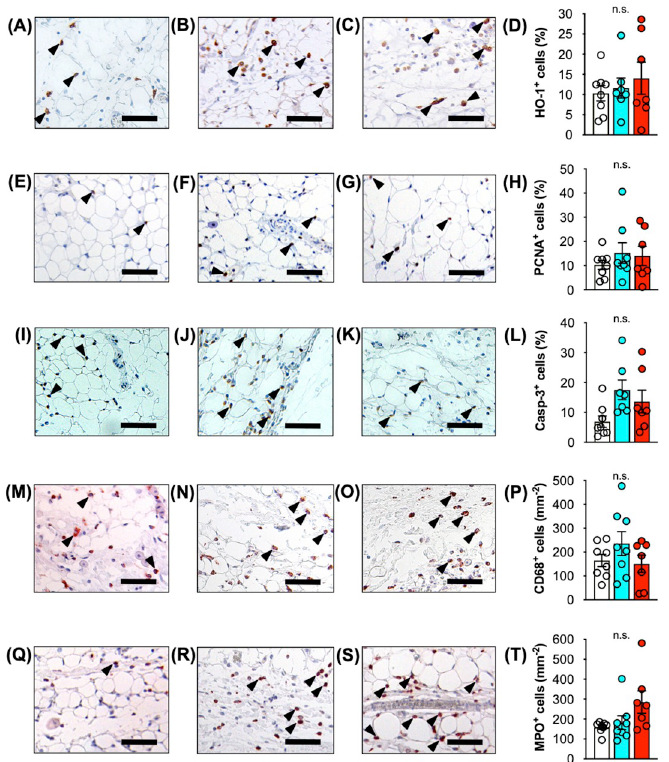
Fig 7. Immunohistochemical analyses of adipose tissue after IR injury. A-D Immunohistochemical detection of HO-1 + cells (arrowheads) in perinodal adipose tissue of control ( A ), IR-45 ( B ) and IR-120 ( C ) VLN flaps. D Quantitative analysis of HO-1 + cells (%). E-H Immunohistochemical detection of PCNA + cells (arrowheads) in perinodal adipose tissue of control ( E ), IR-45 ( F ) and IR-120 ( G ) VLN flaps. H Quantitative analysis of PCNA + cells (%). I-L Immunohistochemical detection of Casp-3 + cells (arrowheads) in perinodal adipose tissue of control ( I ), IR-45 ( J ) and IR-120 ( K ) VLN flaps. L Quantitative analysis of Casp-3 + cells (%). M-P Immunohistochemical detection of CD68 + macrophages (arrowheads) in perinodal adipose tissue of control ( M ), IR-45 ( N ) and IR-120 ( O ) VLN flaps. P Quantitative analysis of CD68 + cells (mm -2 ). Q-T Immunohistochemical detection of MPO + neutrophilic granulocytes (arrowheads) in perinodal adipose tissue of control ( Q ), IR-45 ( R ) and IR-120 ( S ) VLN flaps. T Quantitative analysis of MPO + cells (mm -2 ). Mean ± SEM, n = 7–8, n.s. = not significant. Scale bars = 50 μ m. Casp-3 = cleaved caspase-3, HO = heme oxygenase, IR = ischemia/reperfusion, MPO = myeloperoxidase, PCNA = proliferating cell nuclear antigen, VLN = vascularized lymph node.